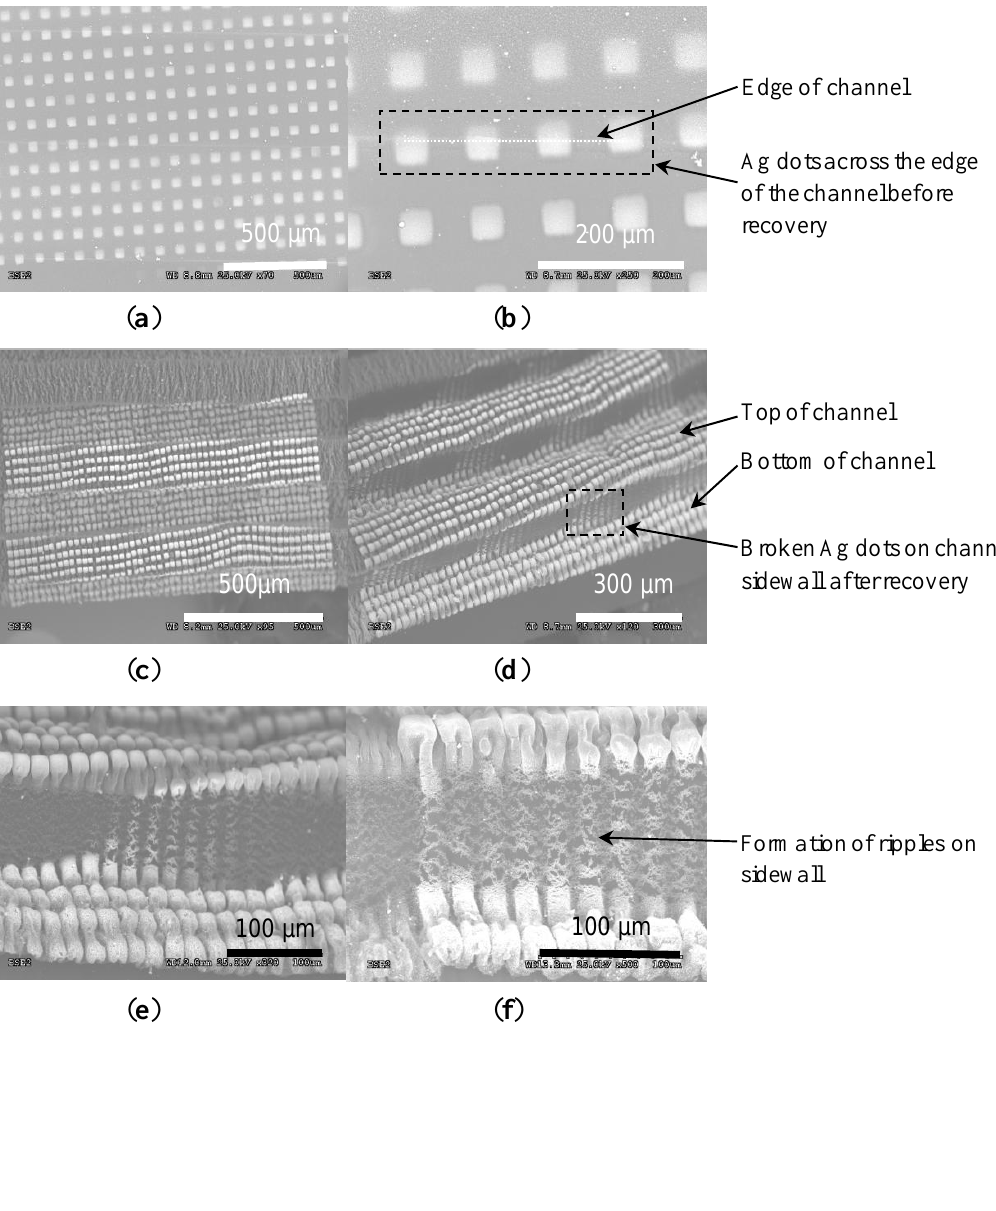
Figure 2. Scanning electron microscopy (SEM) images of 500-µm-wide channels with 50 × 50 µm 2 Ag dots. ( a , b ) Top view of Ag dots before recovery; ( c , d ) Top and side view of the sample after recovery; ( e , f ) Close-up of the vertical sidewall with the broken Ag dots and